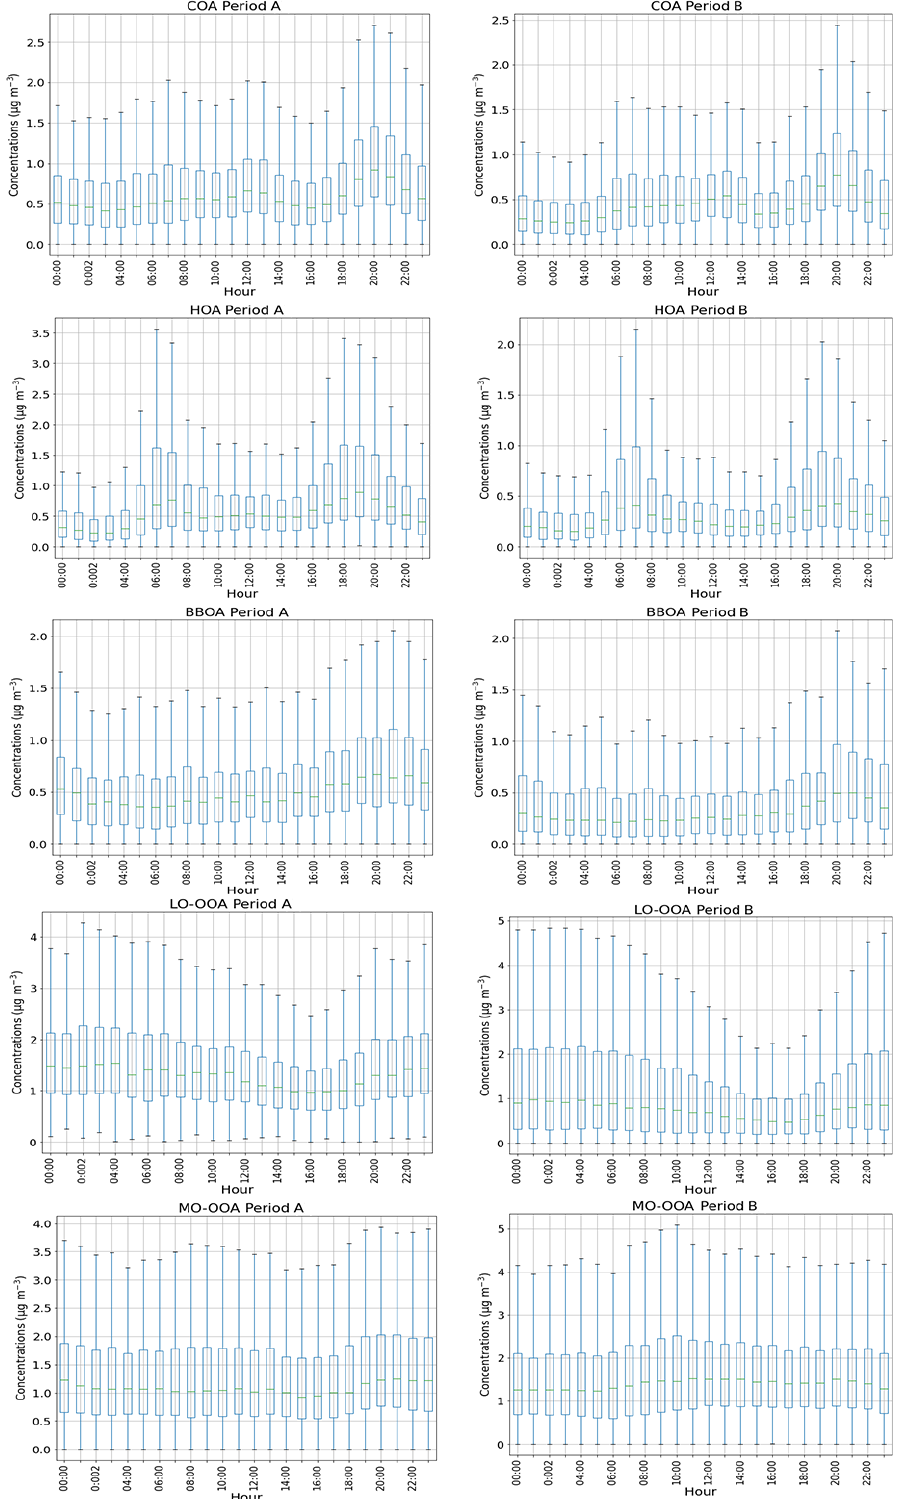
Figure 5. Diel patterns of OA factors concentrations. Boxplots represent median and interquartile range, and whiskers show maximum and minimum values. Factors are in the order COA, HOA, BBOA, LO-OOA and MO-OOA; the left column corresponds to period A and the right one to